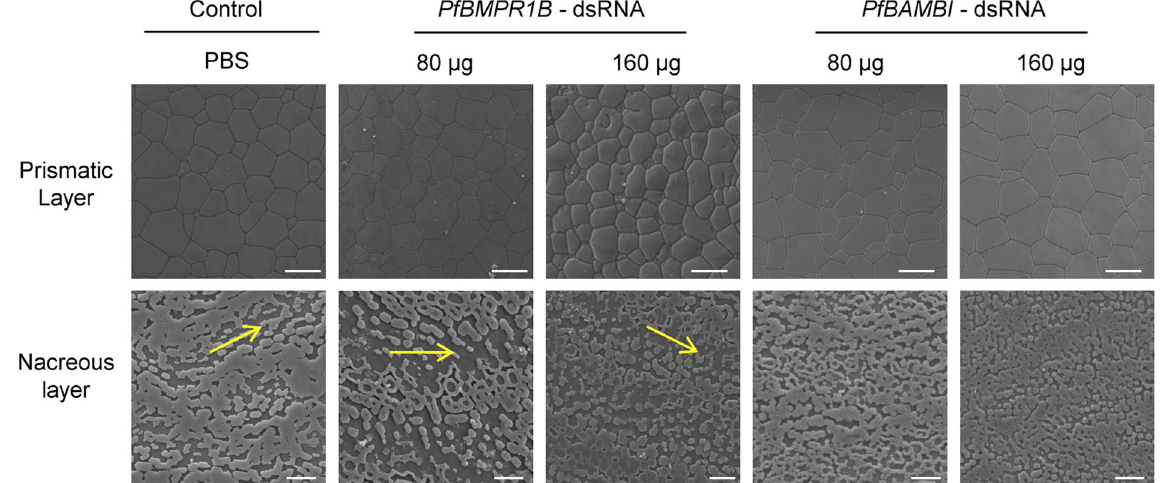
Figure 8. The scanning electron microscope (SEM) images of the ultrastructure of shell inner surface in Pinctada fucata influenced by RNA interference. Bar = 50 μ m for the prismatic layer and Bar = 20 μ m for the nacreous layer. The yellow arrows indicate the growth lines of aragonite crystals on the nacreous layer.